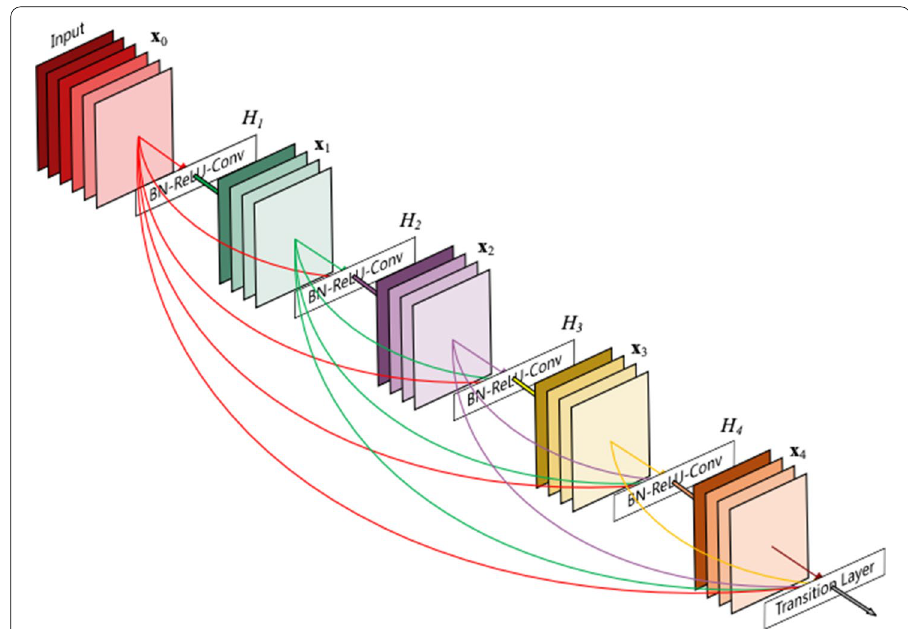
Fig. 22 The architecture of DenseNet Network (adopted from